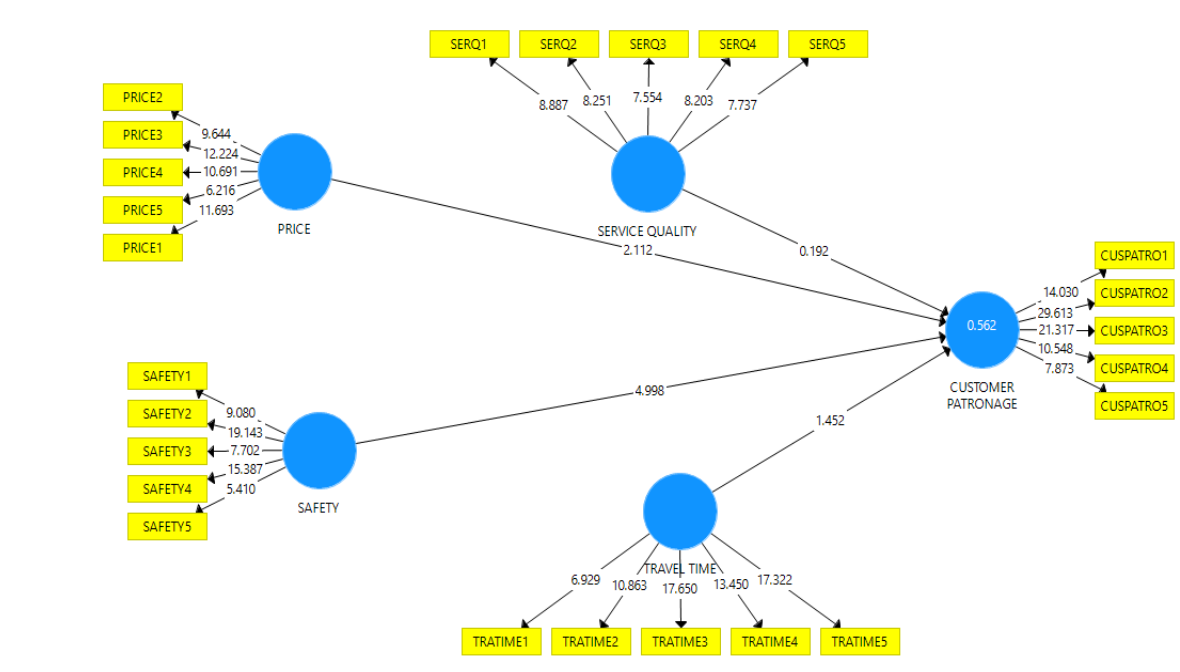
Figure 2: Structural model of railway commuting factors and customer patronage